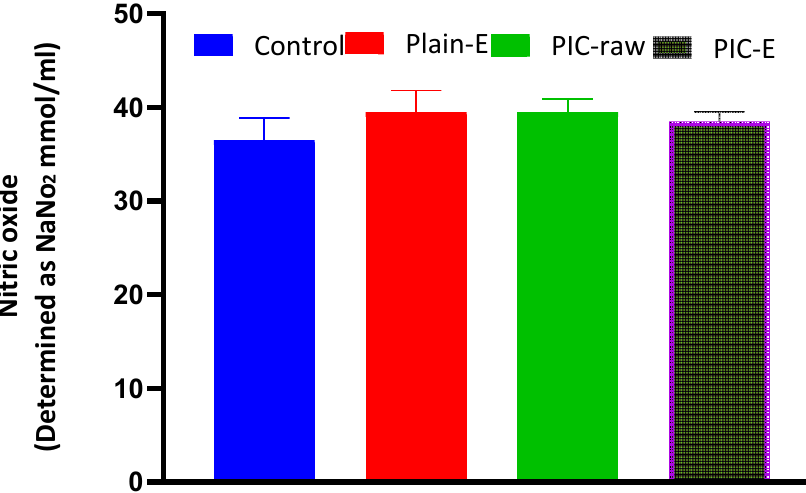
Figure 11. Effect of PIC-E on nitric oxide production in HCT 116 cells. Cells were incubated for 24 h with plain-E, PIC-raw (0.1 µM), or PIC- E (equivalent to 0.1 µM PIC).